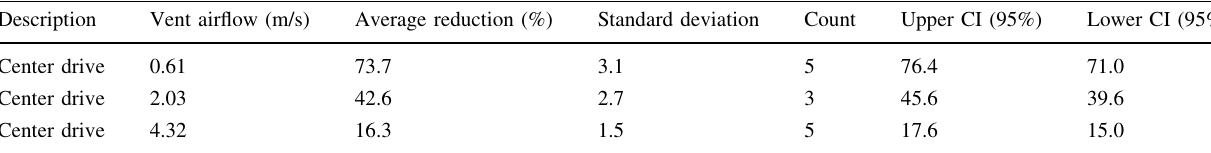
Table 2 Dust control reduction and associated statistics for center-drive shuttle car cabs at different ventilation airflows Description